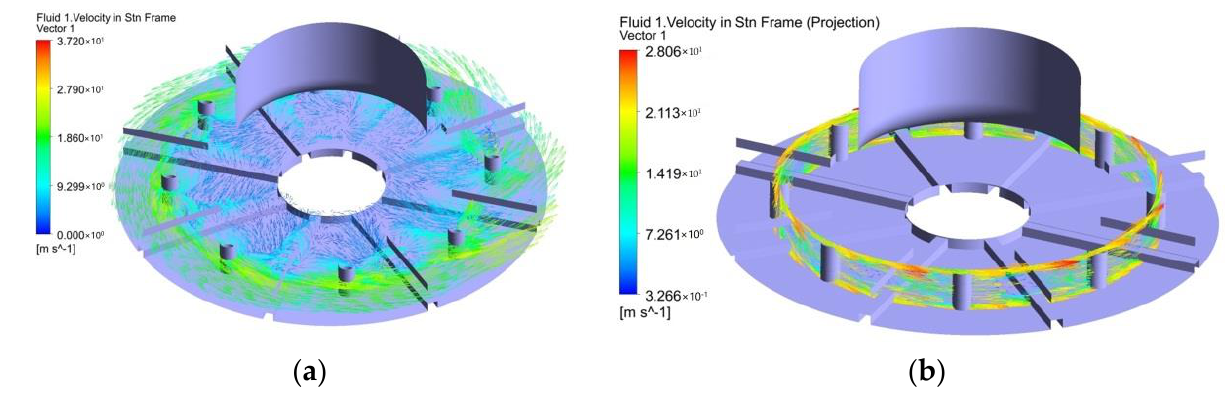
Figure 12. Velocity vector distribution of internal section of blade disc pump impeller ( a , b ).